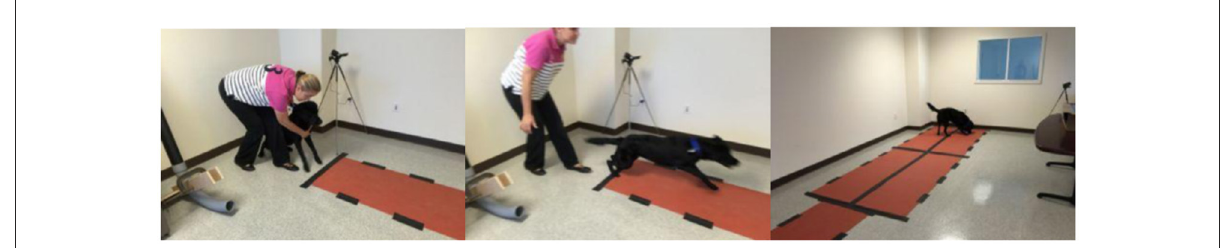
FIGURE1 Ball-Human Sensor experiment setup. The experimenter rolls the ball, and then (left) the dog is mildly restrained for one second, and (middle) released to pursue the ball. The dog then retrieves and interacts with the ball